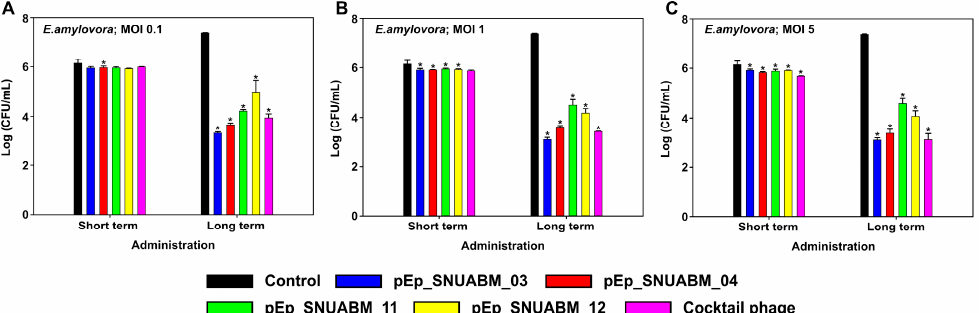
Figure 7. Evaluation of antibacterial activity of phages on Erwinia amylovora . The assay was per- formed at an MOI of 0.1 ( A ), 1 ( B ), and 5 ( C ). Statistical significance was calculated using a one-way analysis of variance (ANOVA) with Holm-Sidak tests ( p <